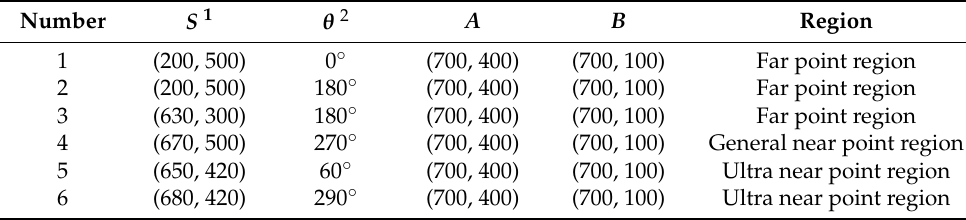
Table 1. Test points that are in different situations.